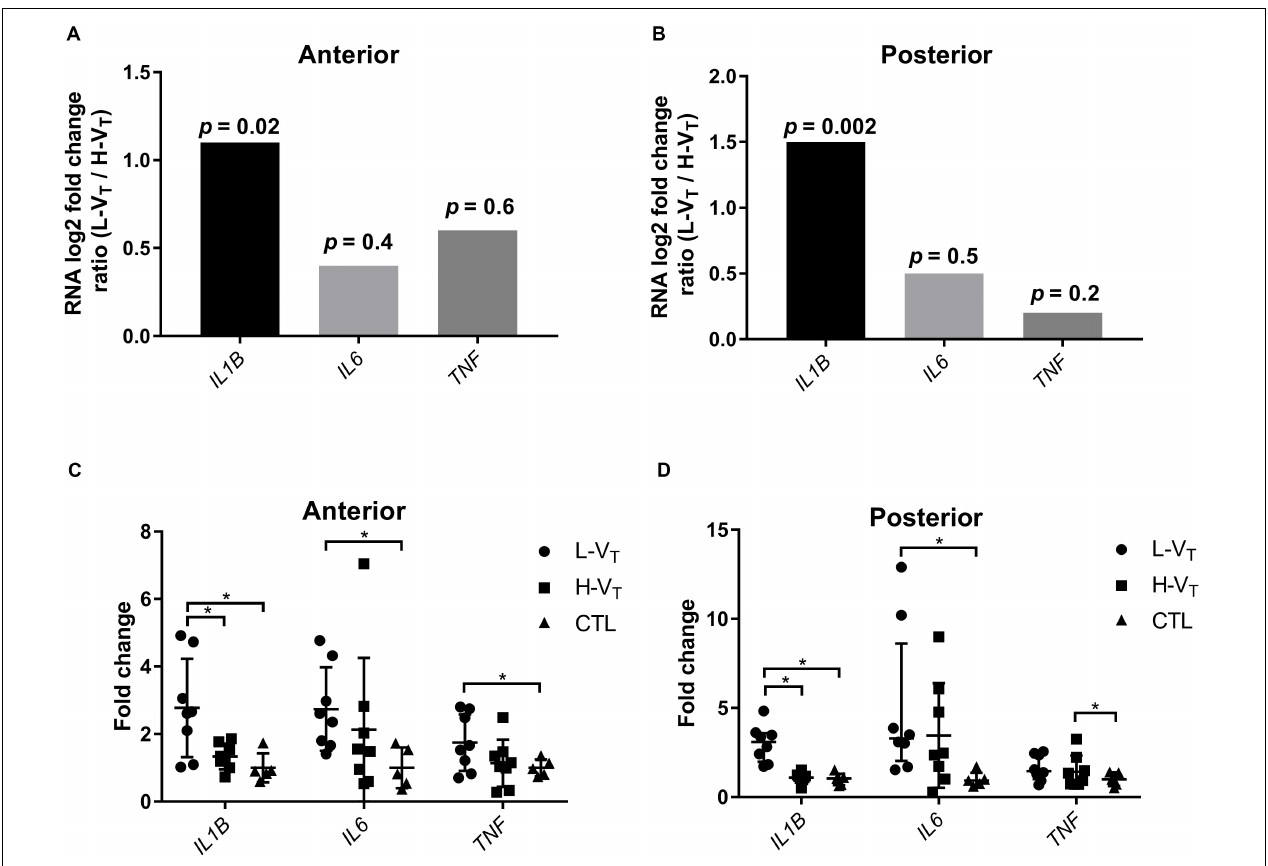
FIGURE 3 | Expression of the IL1B , IL6 and TNF genes illustrated by log 2 fold changes in L-V T relative to H-V T lambs in the anterior (A) and posterior (B) lung regions, and fold changes in gene expression of L-V T , H-V T and unventilated lambs relative to housekeeping genes using qBase relative quantification framework method [glyceraldehyde-3-phosphate dehydrogenase (GAPDH), beta-2-microglobulin (B2M), ribosomal protein L13a (RPL13A), and TATA-binding protein (TBP)] in the anterior (C) and posterior (D) lung regions. Each dot represents a lamb, with mean ± standard deviation. * p < 0.05. See legend of Table 1 for other